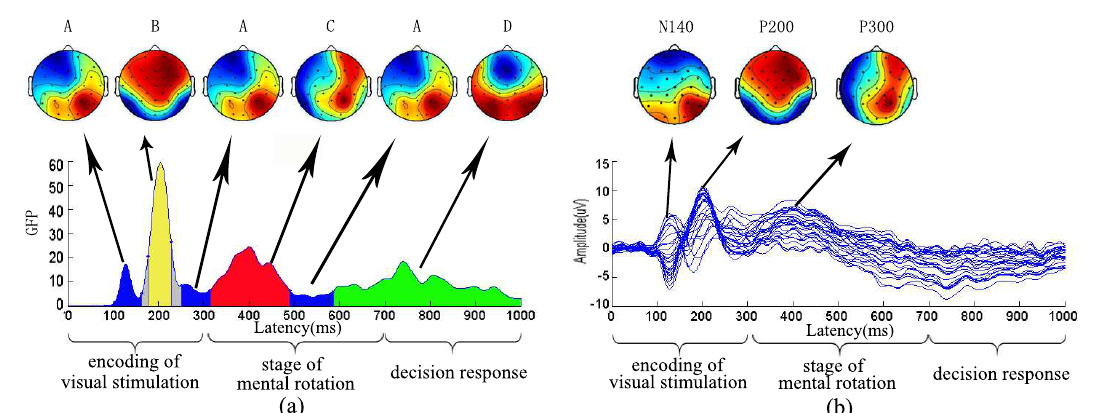
Figure 3. The relationship between microstates and ERP. ( a ) the microstate modes of S1 visual stimulation; ( b ) grand-averaged ERP curves at 28 electrodes for S1 visual stimulation and three brain topographical maps of ERP located at the time intervals corresponding to the N140, P200, P300 components, respectively. In the brain topographical maps, the deep red color represents higher activation and the deep blue color represents weaker